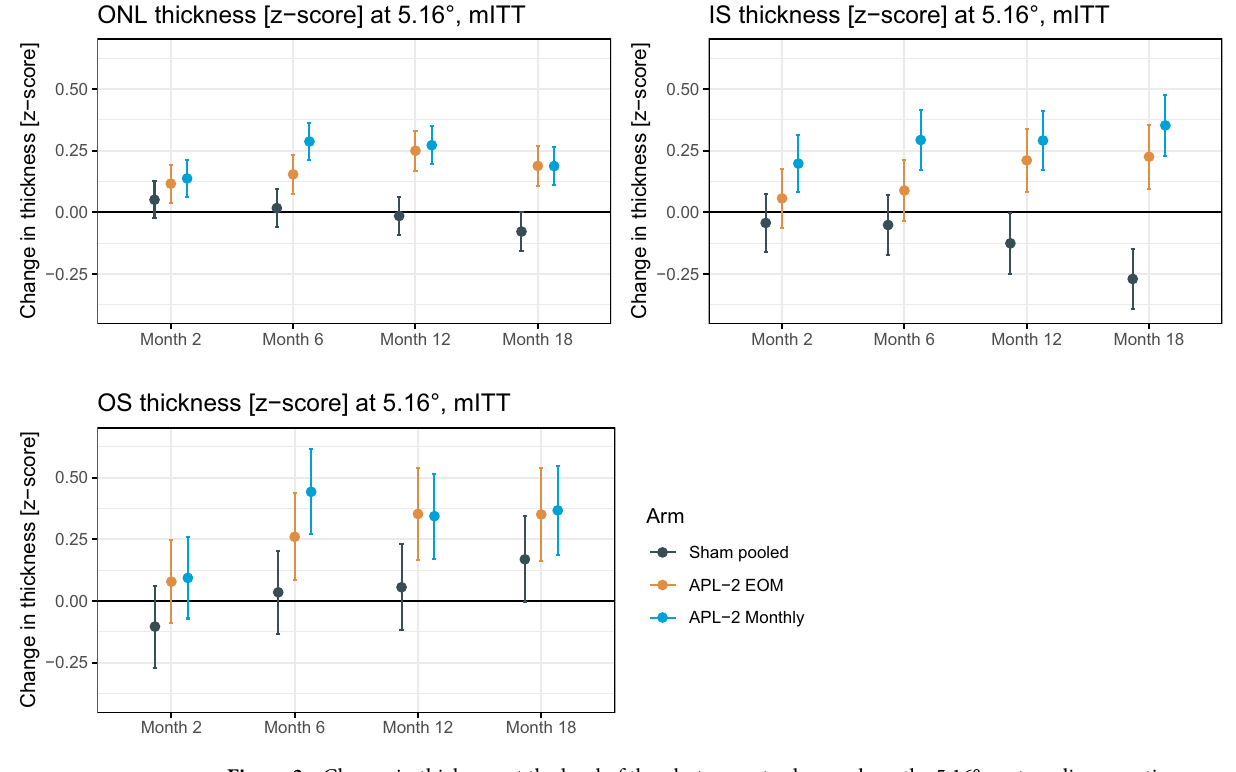
Figure 3. Change in thickness at the level of the photoreceptor layers along the 5.16° contour-line over time, modified intention-to-treat (mITT) analysis. The plots show the least-squares (adjusted) means from the linear mixed model analysis for the change in thickness at the level of the outer nuclear layer (ONL), photoreceptor inner segments (IS), and photoreceptor outer segments (OS) along the 5.16° contour-line as a function of the visit (x-axis) and treatment arm (colors). The vertical lines denote the 95% confidence intervals. Eyes treated with pegcetacoplan (APL-2) monthly tended to show a reduced degree of photoreceptor laminae thinning over time. Participants were treated between baseline and month 12. The data were derived from the modified intention-to-treat (mITT) analysis (N participants = 192). Outer nuclear layer (ONL), photoreceptor inner segments (IS), photoreceptor outer segments (OS), modified intention-to-treat